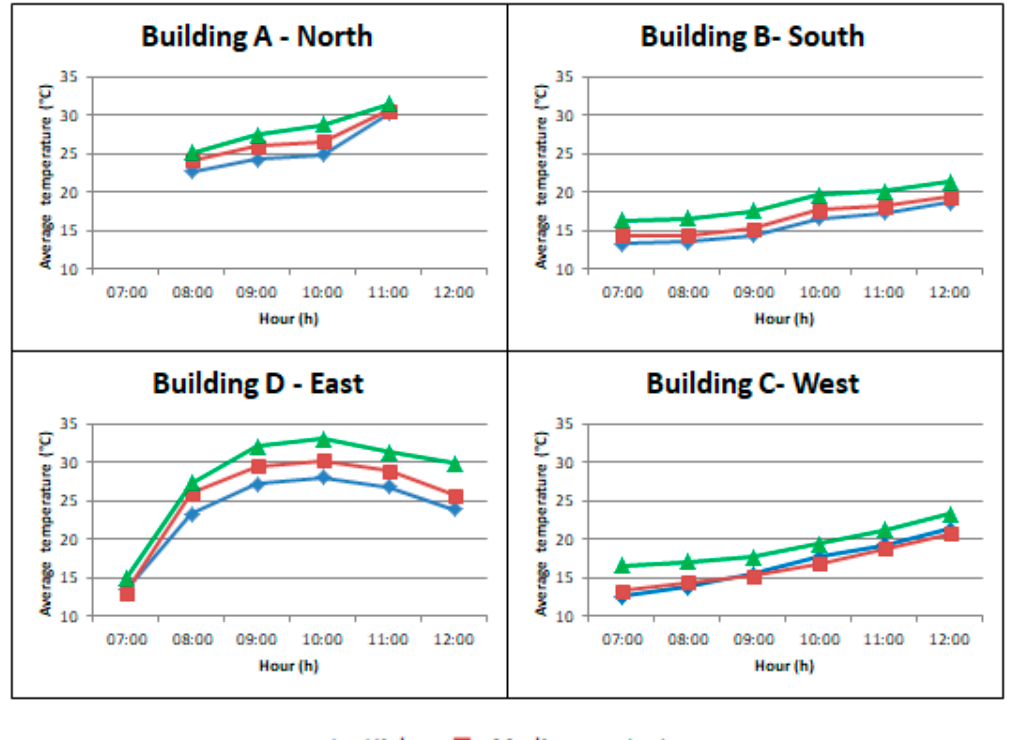
Figure 1. Variation of average temperature with